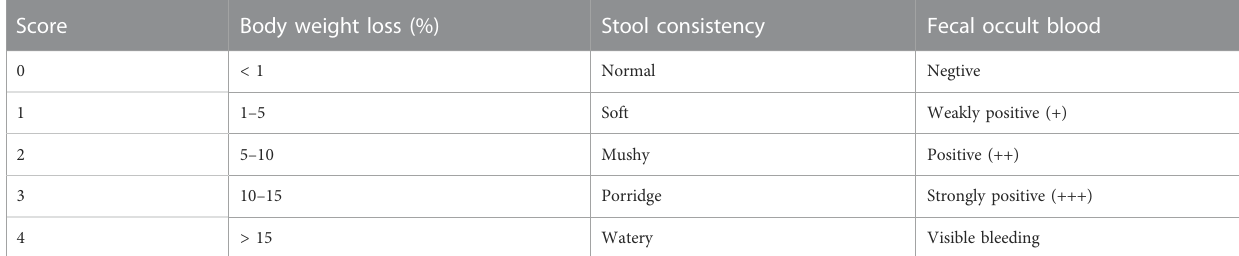
TABLE 2 Disease activity index